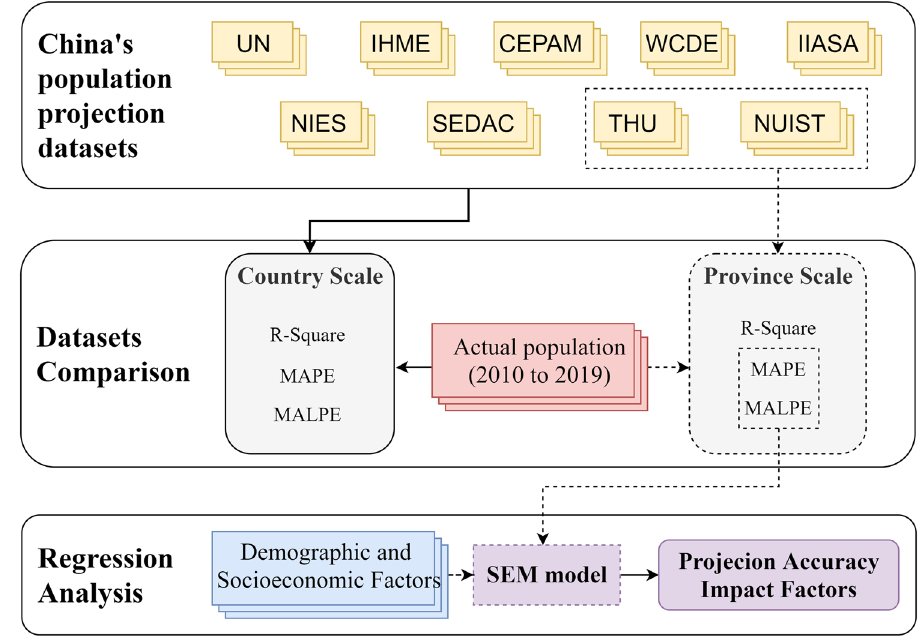
Figure 1. Workflow of the research.